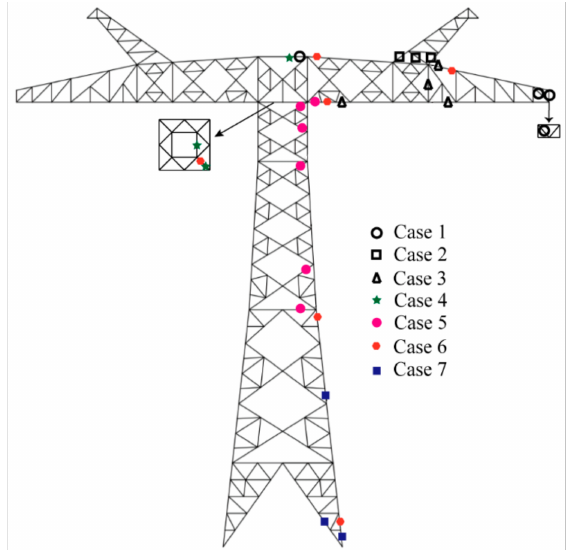
Figure 5. Key observation parts of each load case.